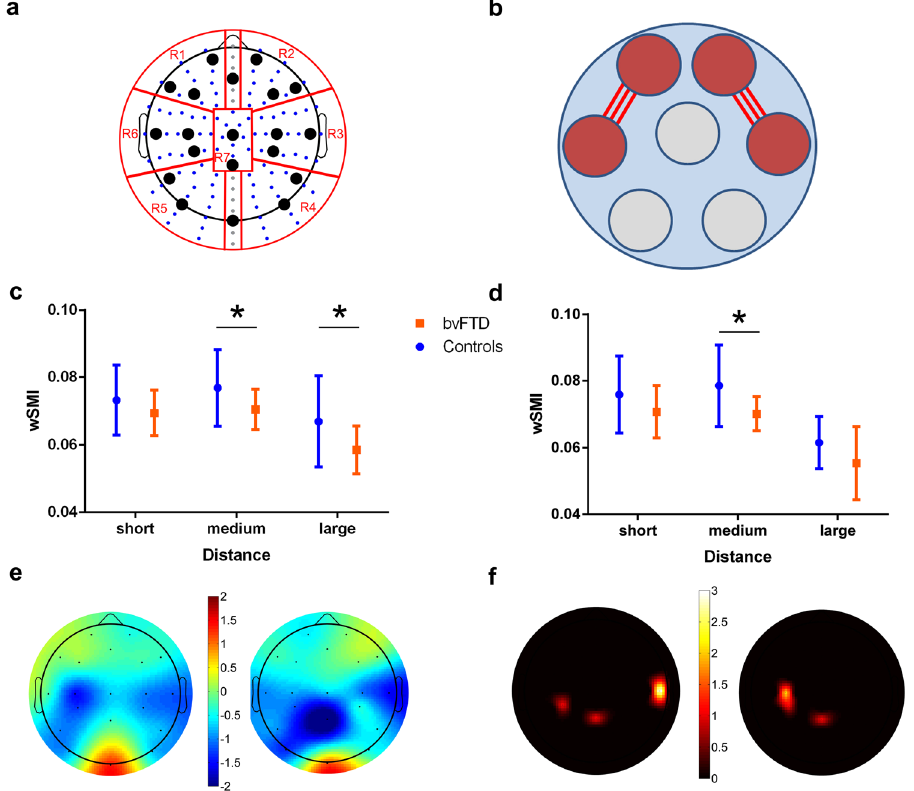
Figure 3. Functional connectivity analysis for a subset of 20 electrodes. ( A ) ROIs defined to analyze specific topographic connectivity: left frontal (R1), right frontal (R2), right temporal (R3), right posterior (R4), left posterior (R5), left temporal (R6), and central (R7). Marked electrodes in black are subset of 20 electrodes used in these analyses. ( B ) Average connectivity between regions: significant differences in average connectivity were found between the right frontal and right temporal ROIs (bvFTD: M = 0.065, SD < 0.01; controls: M = 0.075, SD = 0.01; p- value = 0.05,), and between the left frontal and the left parietal ROIs (bvFTD: M = 0.065, SD < 0.01; controls: M = 0.072, SD < 0.01; p- value = 0.05). ( C ) Connectivity as a function of distance of the left frontal ROI. Mean connectivity was calculated for the three distance ranges (short = 0.5–0.8, medium = 0.8–1.4, long = 1.4–1.8). Using permutation tests with 1000 iterations, we found significant differences for the medium ( p -value = 0.04) and long ( p -value = 0.02) ranges. ( D ) Connectivity as a function of distance of the right frontal ROI. Mean connectivity was calculated for the three distance ranges (short = 0.5–0.8, medium = 0.8–1.4, long = 1.4–1.8). Using permutation tests with 1000 iterations, we found significant differences for medium range connections ( p -value = 0.01). ( E ) Seed analysis (median values): scalp maps of the median value of p - values (from Wilcoxon tests between bvFTD patients and controls) are shown for the left frontal (left) and right frontal (right) seeds. The color bar indicates -log [median ( p -values)] times the sign of W, where W is the Wilcoxon statistics minus the expected value under the null hypothesis. Values > 1.3 or < − 1.3 are statistically significant. ( F ) Seed analysis (FDR correction): scalp maps quantifying the number of connections (associated to the seed ROI) yielding differences ( p -value from Wilcoxon tests between bvFTD patients and controls with FDR < 0.05) for each electrode. The maps show the results for the left frontal (left) and the right frontal (right) seeds. The color bar indicates the number of connections with statistically significant differences ( p -values <